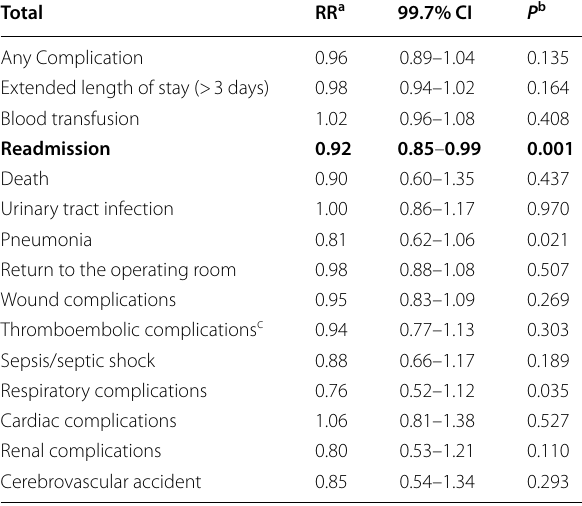
risk of complications in the